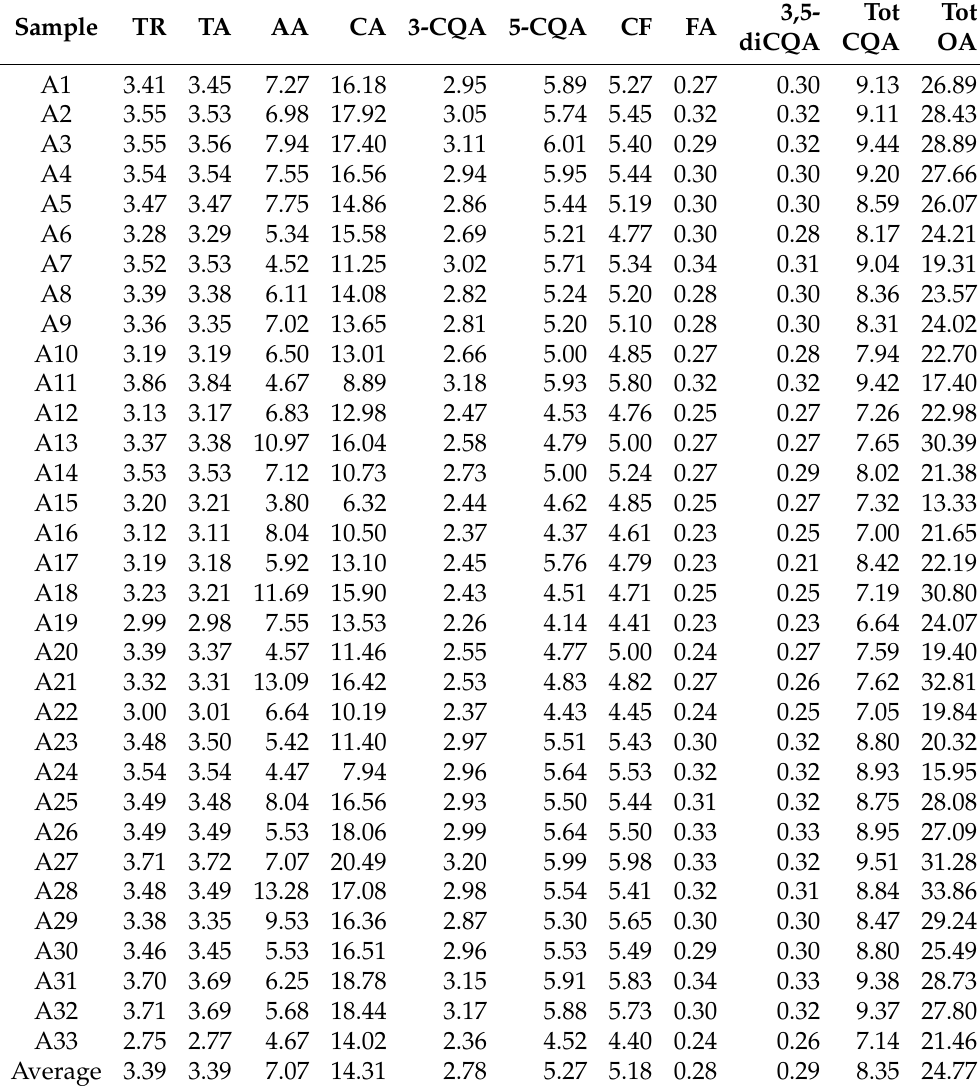
Table 4. Contents of bioactive compounds (g/L) found in Arabica EC samples. TR denotes trigonelline, TA tartaric acid, AA acetic acid, CA citric acid, CF caffeine, FA ferulic acid, CQA chlorogenic acid, OA organic acid. % RSD for all compounds are from 0.3 to